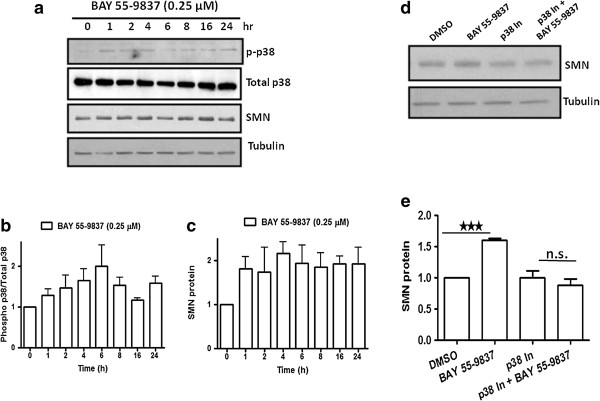
BAY 55-9837 treatment increases SMN expression via p38 MAPK pathway. (a) Representative western blot showing activation of p38 MAPK pathway upon BAY 55-9837 treatment in NT2 cells. NT2 cells were treated with BAY 55-9837 at indicated times and then harvested for western blot analysis. Activation of p38 pathway by BAY 55-9837 leads to an increase in SMN protein. (b) Densitometric quantification of phospho-p38 relative to total-p38 (the ratio at control treatment was set as 1; mean + SEM (bars) of three independent experiments) are shown for NT2 cells. (c) Densitometric quantification of SMN protein relative to Tubulin (the ratio at control treatment was set as 1; mean + SEM (bars) of three independent experiments) are shown for NT2 cells. (d) Representative western blots showing the effect of p38 inhibition on BAY 55-9837-induced increase in SMN protein. p38 inhibitor (SB-239580) blocked the BAY 55-9837-induced increase in SMN protein in NT2 cells. NT2 cells were treated with SB-239580 (p38 In; 3 μM) for 2 h followed by treatment with BAY 55-9837 for 24 h and than harvested for western blot analysis. (e) Densitometric quantification of SMN protein relative to Tubulin (the ratio at control treatment was set as 1; mean + SEM (bars) of three independent experiments) are shown for NT2 cells showing the effect of p38 inhibition on BAY 55-9837-induced increase in SMN protein. *P < 0.05; **P < 0.01, t-test.